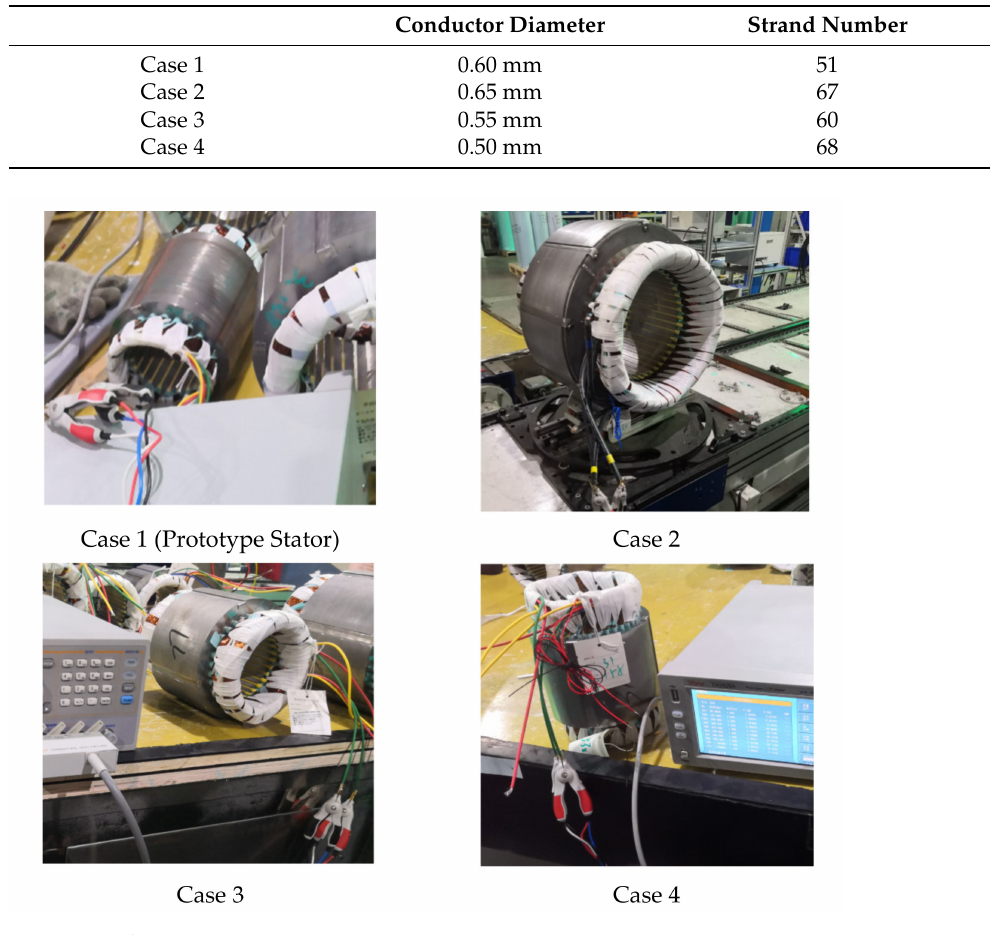
Figure 28. The test